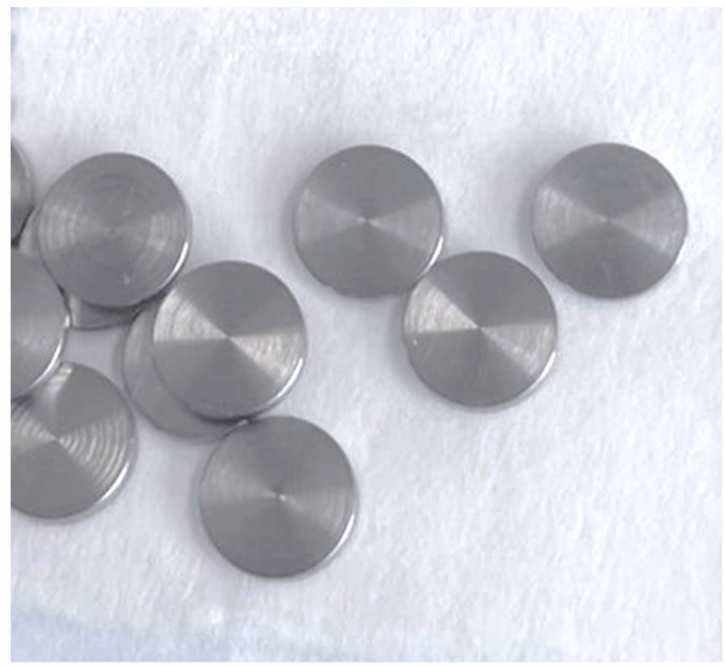
Figure 1. View of the titanium discs before the